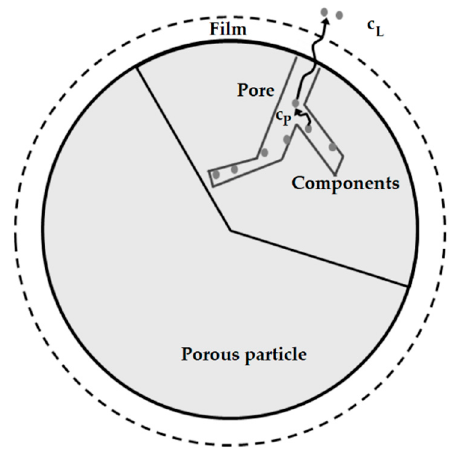
Figure 7. Schematic representation of the pore di ff usion model Figure 7 . Schematic representation of the pore diffusion model [12] .